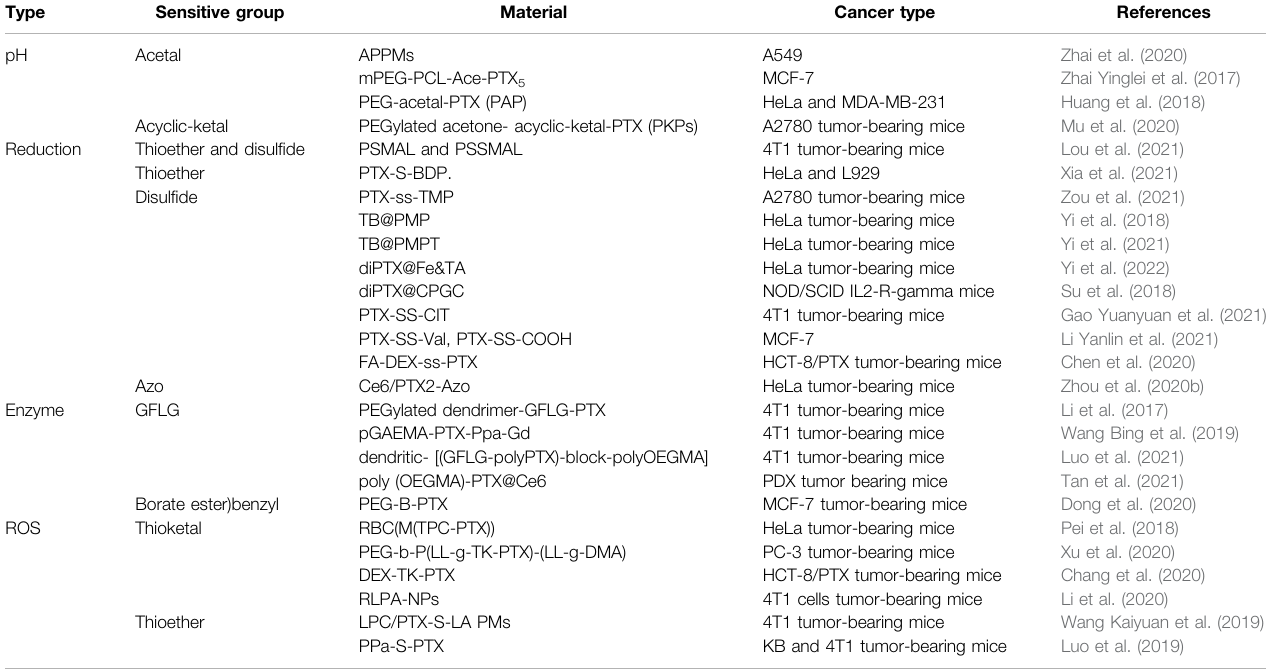
TABLE 1 | Summary of representative systems for PTX